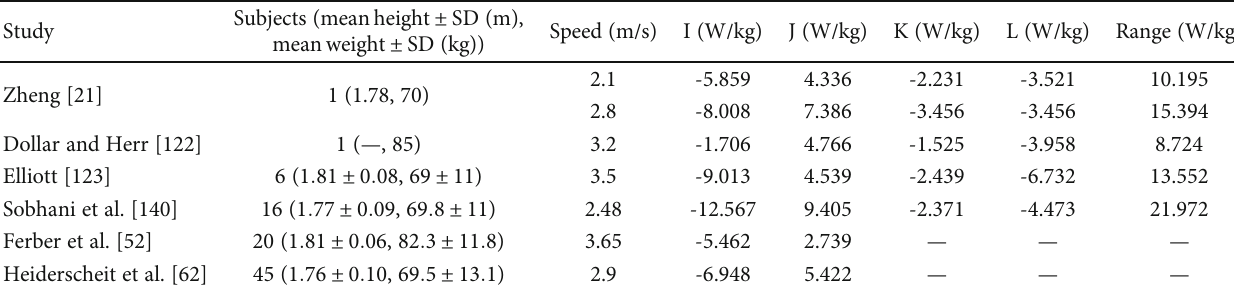
Table 6: Overview over the experimental results of knee power for